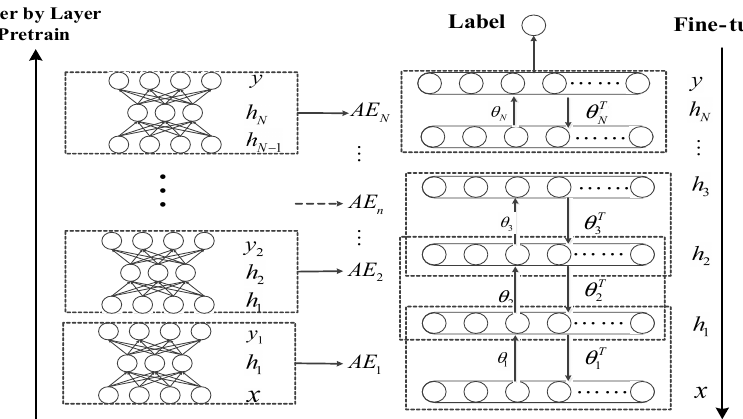
Figure 1. The structure of a deep neural network (DNN).